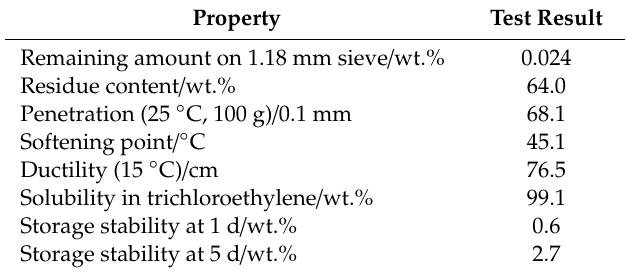
Table 1. Properties of asphalt emulsion.